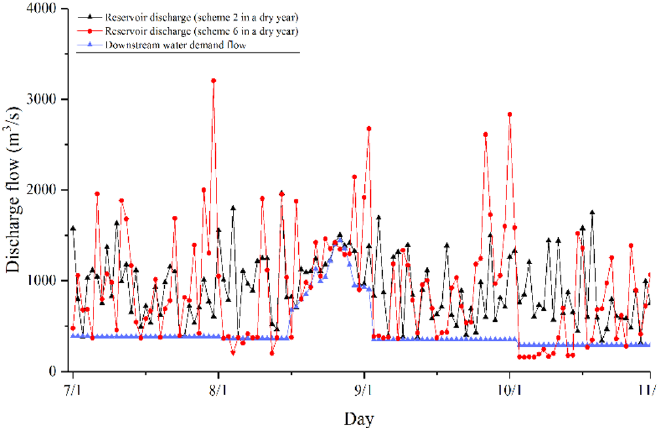
Figure 12. Daily flow process lines in a dry year.